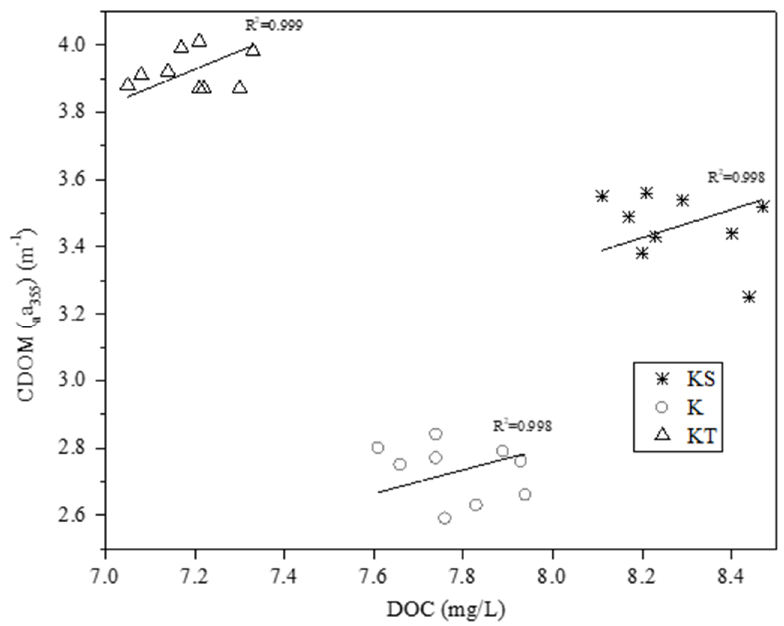
Figure 4. Relationship between DOC and CDOM in KS, K and KT, n = 9.